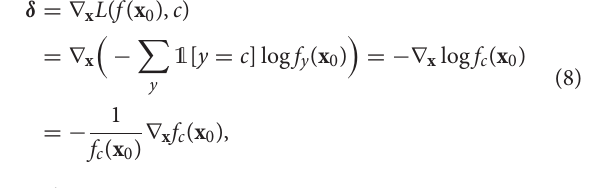
it maximizes the loss. The outer problem trains model parameters to minimize the